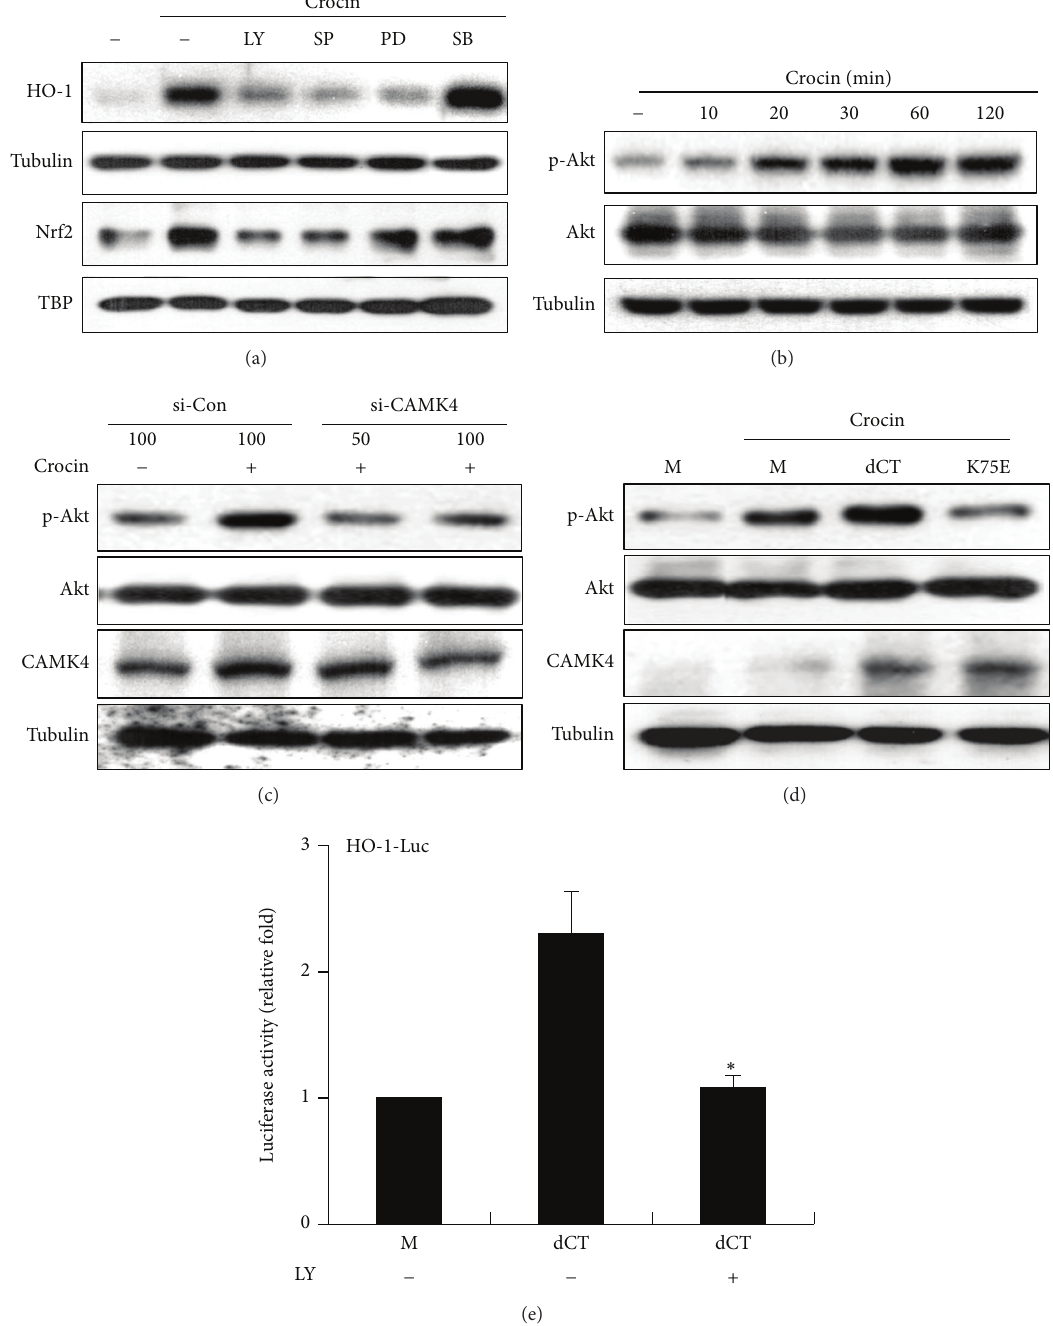
Figure 8: Akt acts as a downstream regulator of CAMK4 in crocin-mediated HO-1 expression. (a) RAW 264.7 cells were incubated with LY294002 (20 𝜇 M), SP600125 (20 𝜇 M), PD98059 (20 𝜇 M), and SB203580 (20 𝜇 M) for 1h and then treated with crocin (500 𝜇 M) for 6h. Equal amounts of cytosolic and nuclear extract were subsequently analyzed by Western blotting with HO-1 and Nrf2 antibody, respectively. Tubulin and TBP were used as loading controls. (b) Cells were incubated with crocin (500 𝜇 M) for the indicated times. (c) Cells were transfected with CAMK4 siRNA or control siRNA and then treated with crocin (500 𝜇 M) for 1h. (d) Cells were transfected with pcDNA3.1 (mock, M), CAMK4 constitutive active (dCT), or kinase dead (K75E) construct and then treated with crocin (500 𝜇 M) for 1h, after which equal amounts of cytosolic extract were analyzed by Western blotting. (e) Cells were cotransfected with HO-1-luciferase construct and pcDNA3.1, or dCT and then treated with LY294002 (20 𝜇 M). Equal amounts of cell extracts were then assayed for dual luciferase activity. ∗ 𝑃 < 0.05 versus the dCT-transfected (no LY294002)